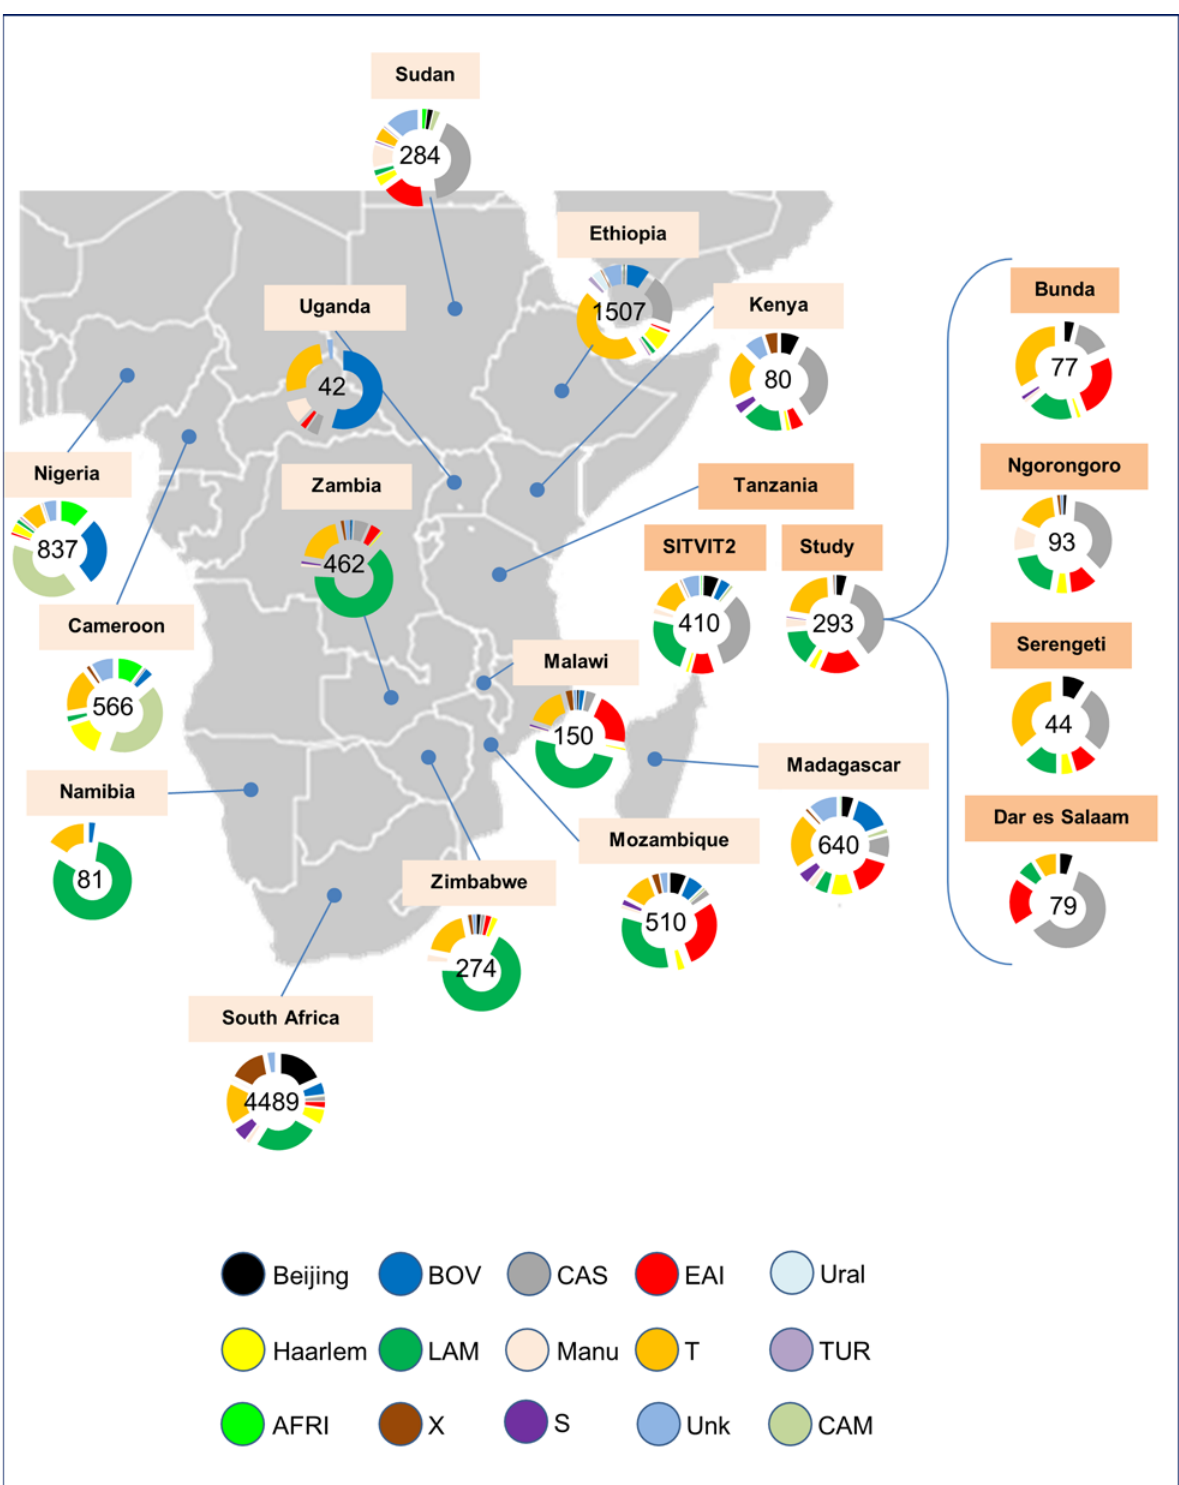
Fig 1. Distribution map of Mycobacterium tuberculosis lineages in several countries of Africa according to the SITVIT2 database.